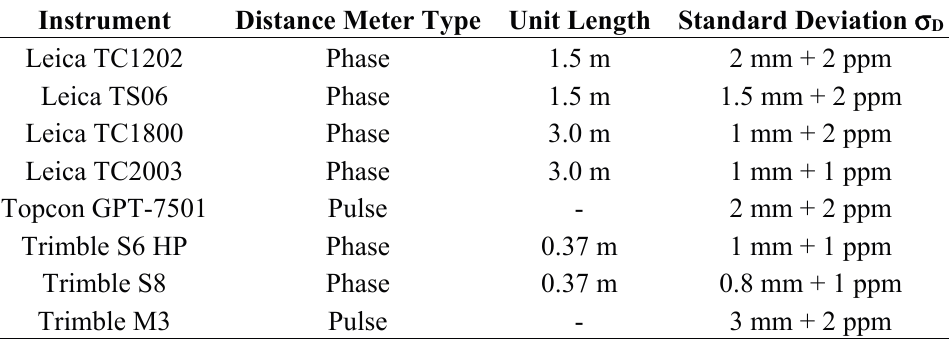
Table 2. Overview of tested